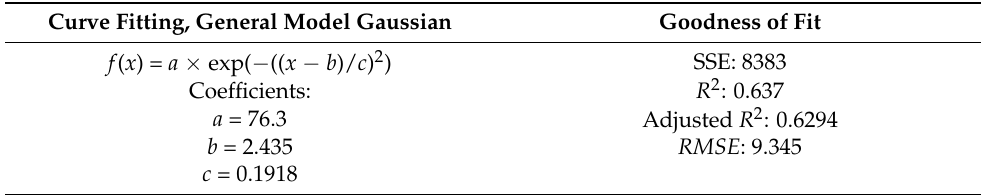
Table 6. Gaussian curve fitting model parameters for P vs. Df . Curve Fitting, General Model